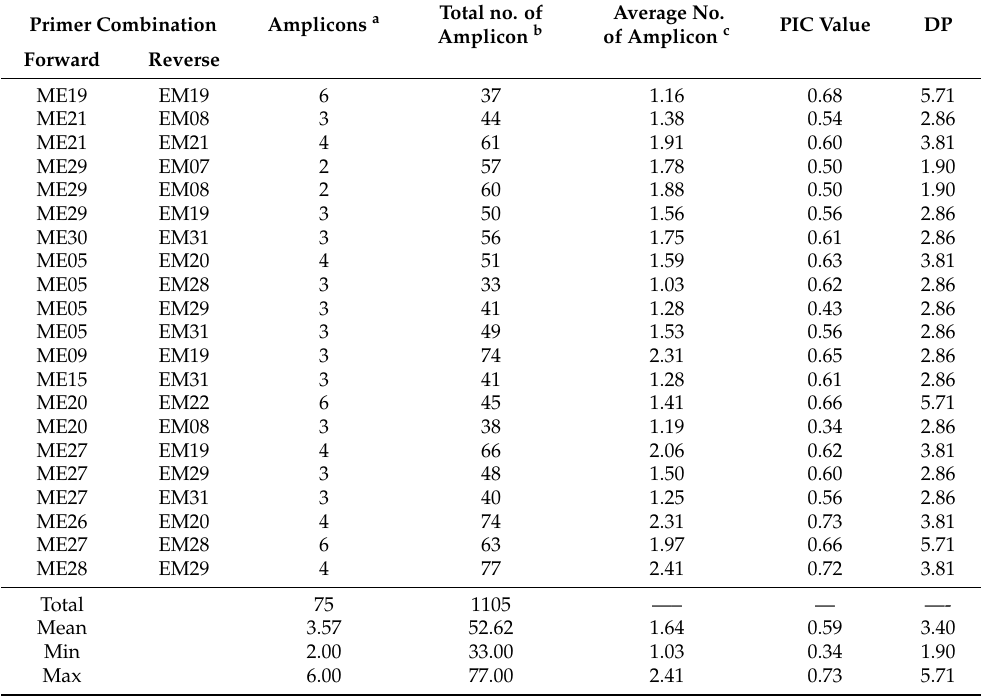
Figure 4. Dendrogram of the 32 quinoa genotypes based on SRAP markers using Jaccard’s coefficient and the UPGMA clustering method. Numbers at the branches indicate bootstrap values, computed from 100 replications of the data. Table 4. The features of sequence-related amplified polymorphism (SRAP) primers were selected regarding quinoa genetic